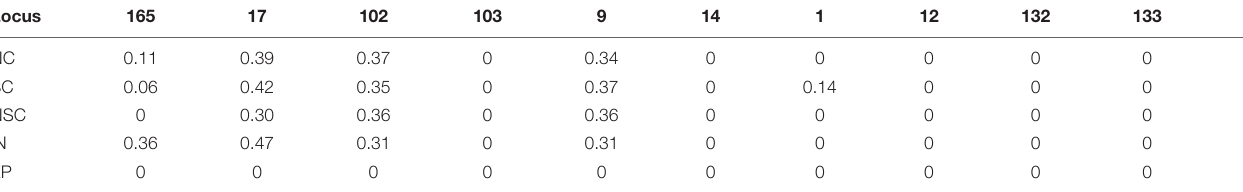
TABLE 3 | Polymorphism information of CNVs in five studied populations at 11 loci. Locus